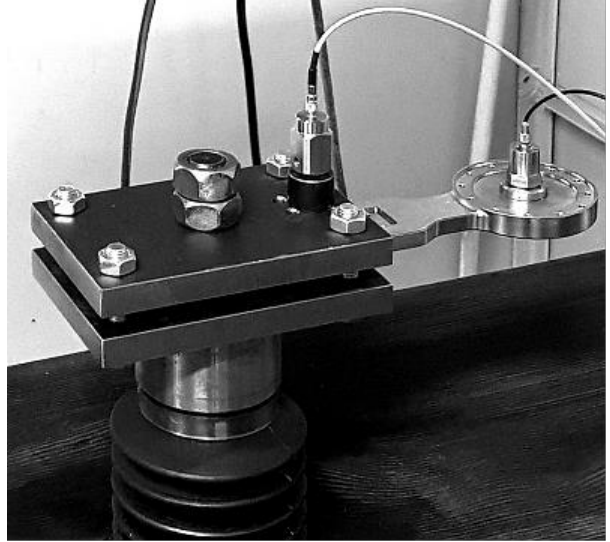
Figure 4. The device mounted on the hydropulse. Table 1. PZT accelerometers characteristics.